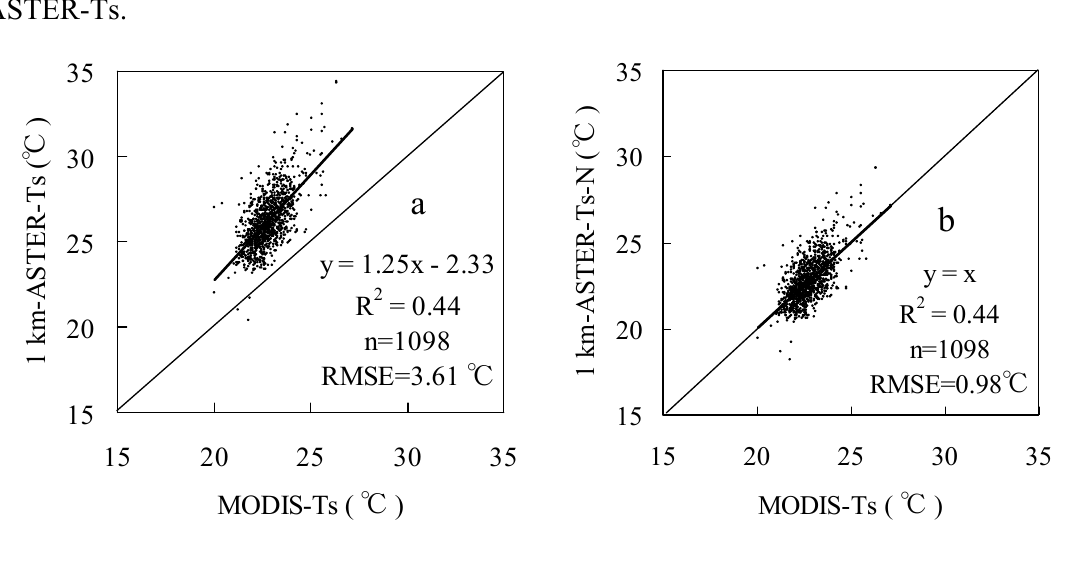
Figure 3. Comparisons of MODIS-Ts with (a) 1 km-ASTER-Ts and (b) normalized 1 km-